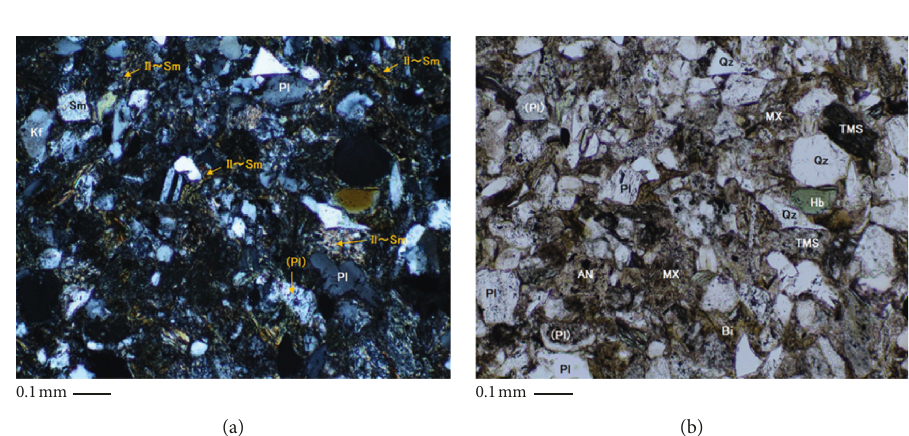
Figure 1: Microscopic images of the Kushiro Cretaceous sandstone. Qz: quartz ( ϕ ≤ 0.2–0.4mm), Pl: plagioclases ( ϕ ≤ 0.2mm), Mx: matrix (Sm–Il: smectite–illite (silt-size mineral pieces)), Kf: potash feldspar ( ϕ ≤ 0.2 mm), Bi: biotite ( ϕ ≤ 0.2–0.5mm), Hb: ordinary amphibole ( ϕ ≤ 0.15mm), AN: andesite ( ϕ ≤ 0.2mm), TMS: transformed mudstone ( ϕ ≤ 0.25mm), Mc: mica, and Chl: Table 2: Mineral composition of the Kushiro Cretaceous sandstone from XRD analysis. Qz Pl Kf